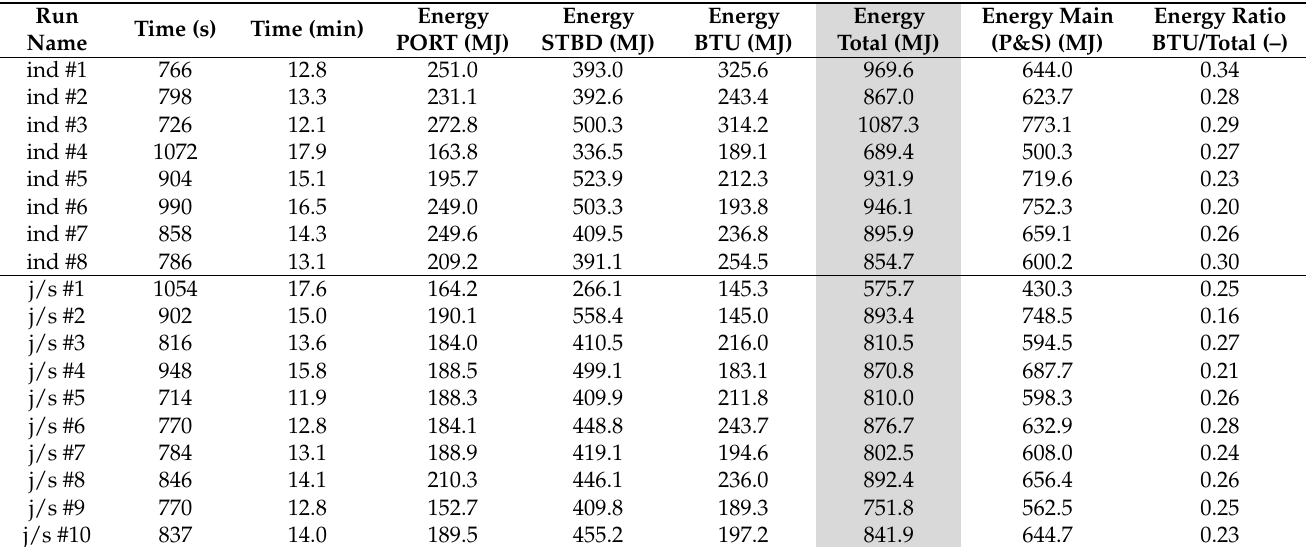
Table 1. Details of the simulation experiment output.